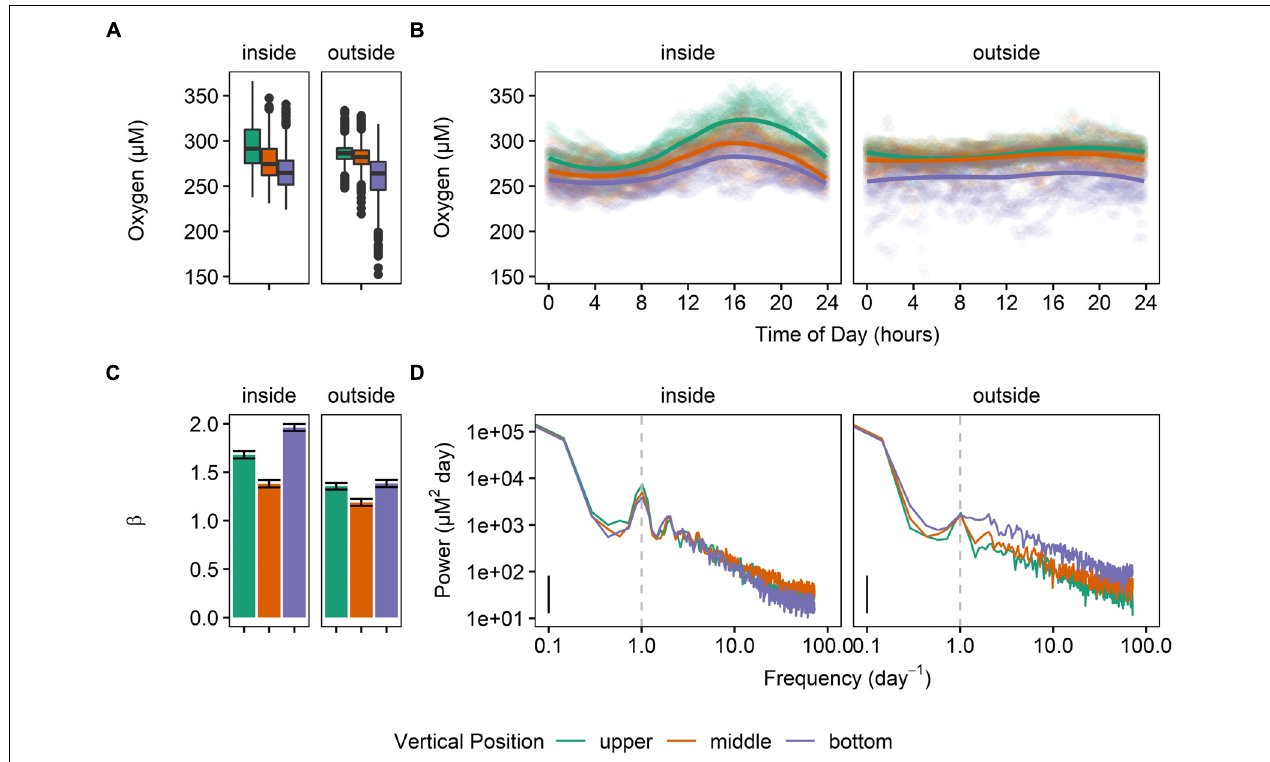
FIGURE 2 | Dissolved oxygen regimes at MKO for Deployment 1 (June 2 – June 23, 2014), where six oxygen sensors were deployed (two locations and three depths) inside and outside of the kelp forest. (A) Boxplots of the oxygen values, taken every 10 min. (B) Mean daily swings of oxygen. (C) β indexes calculated for the entirety of the deployment, after subtracting the diurnal signal. (D) Power spectra of the deployment for each sensor.